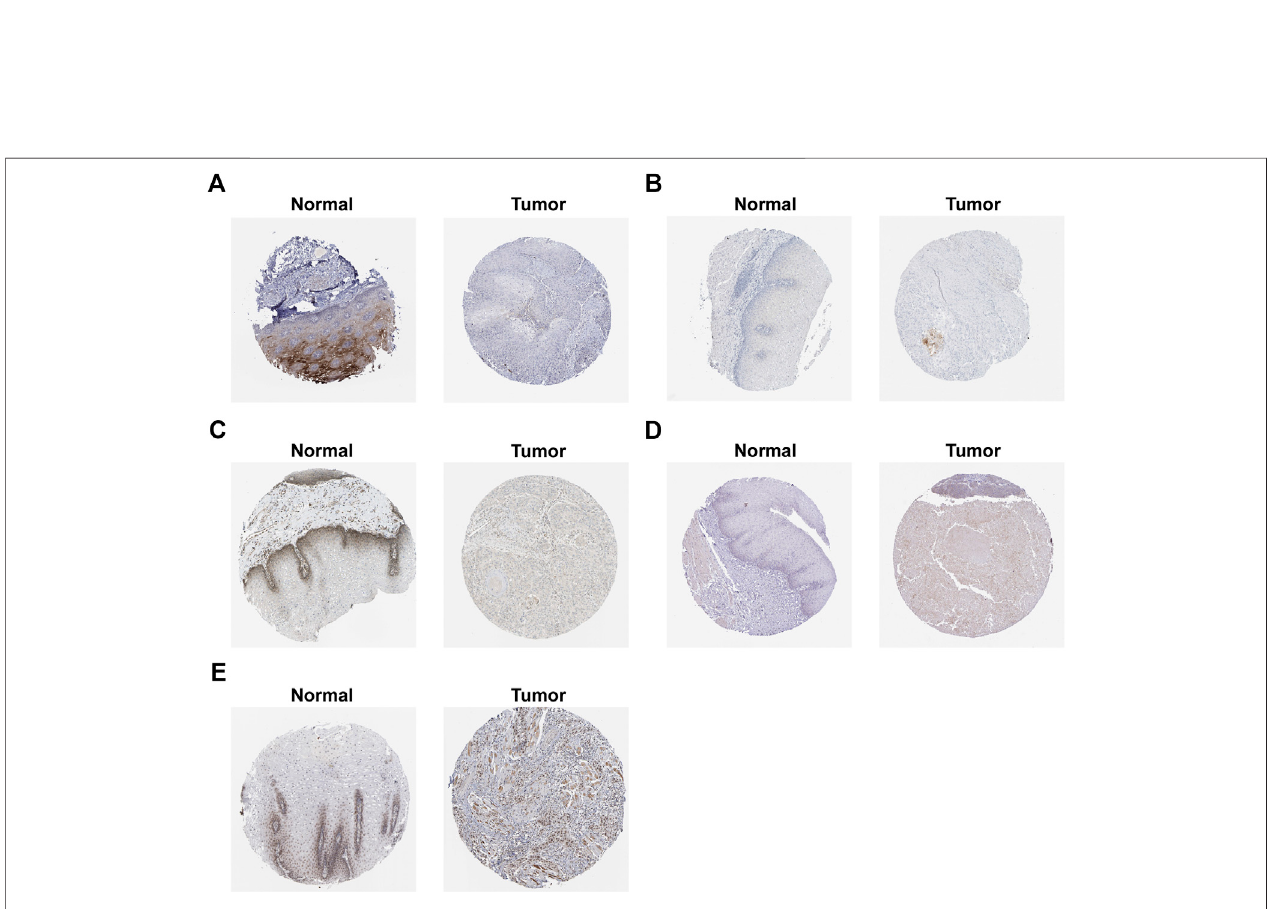
FIGURE8| ProteinexpressionofsignaturegenesinHPAdatabase. (A) proteinexpressionofALOX12. (B) proteinexpressionofALOX12B. (C) proteinexpression of MAPK9. (D) protein expression of SLC38A1. (E) protein expression of ZNF419.